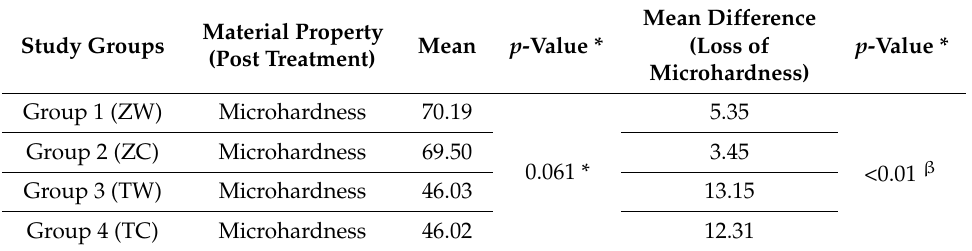
Table 3. Comparison of post treatment micro-hardness (VHN) among study groups. Table 2. Comparison of Microhardness (VHN) means among study groups. Study